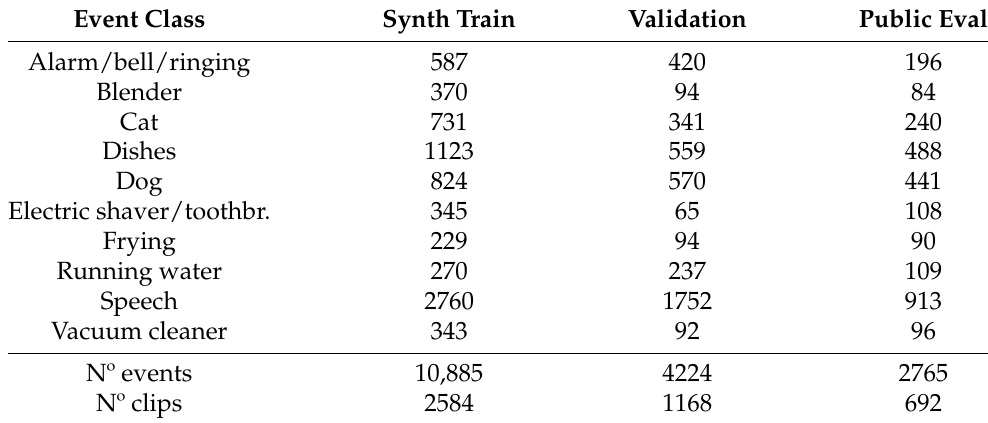
Table 1. Number of events per class in the strongly labeled DESED subsets: Synth Training, Validation, and Public Evaluation, and total number of events and audio clips in each set. The total number of events and sound clips in each dataset is presented in the bottom